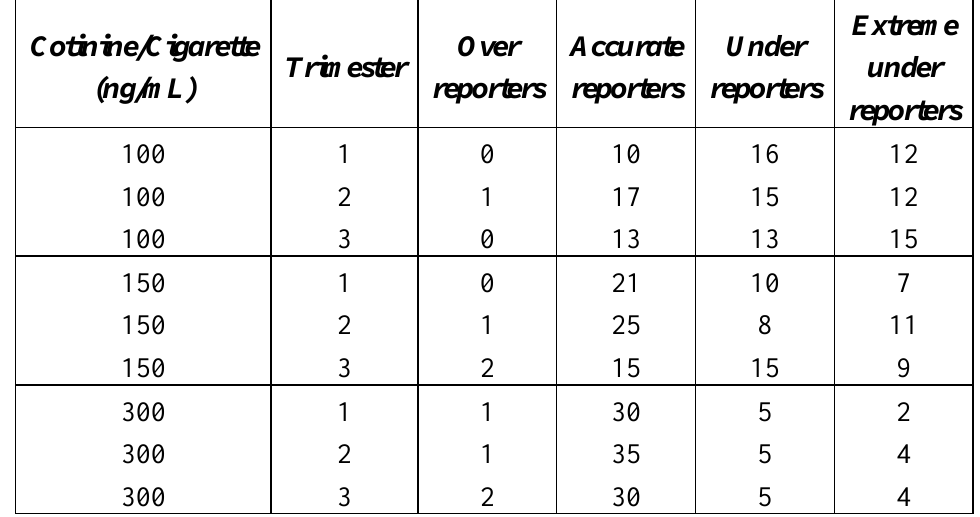
Table 6. The number of women classified into each group in each trimester, using different values of urinary cotinine a cigarette produces. Rows 1-3 use 100 ng/mL, rows 4-6 use 150 ng/mL, and rows 7-9 use 300